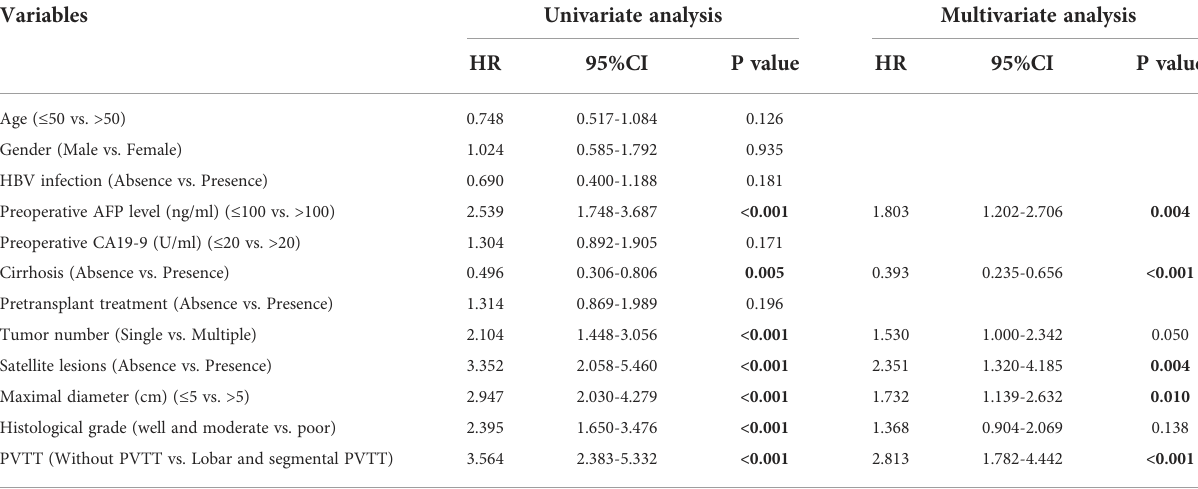
TABLE 5 Univariate and multivariate analysis of prognosis factors for recurrence-free survival in patients who underwent deceased LT.